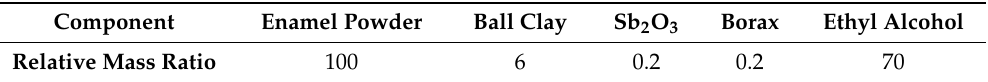
Table 2. Chemical composition of the enamel